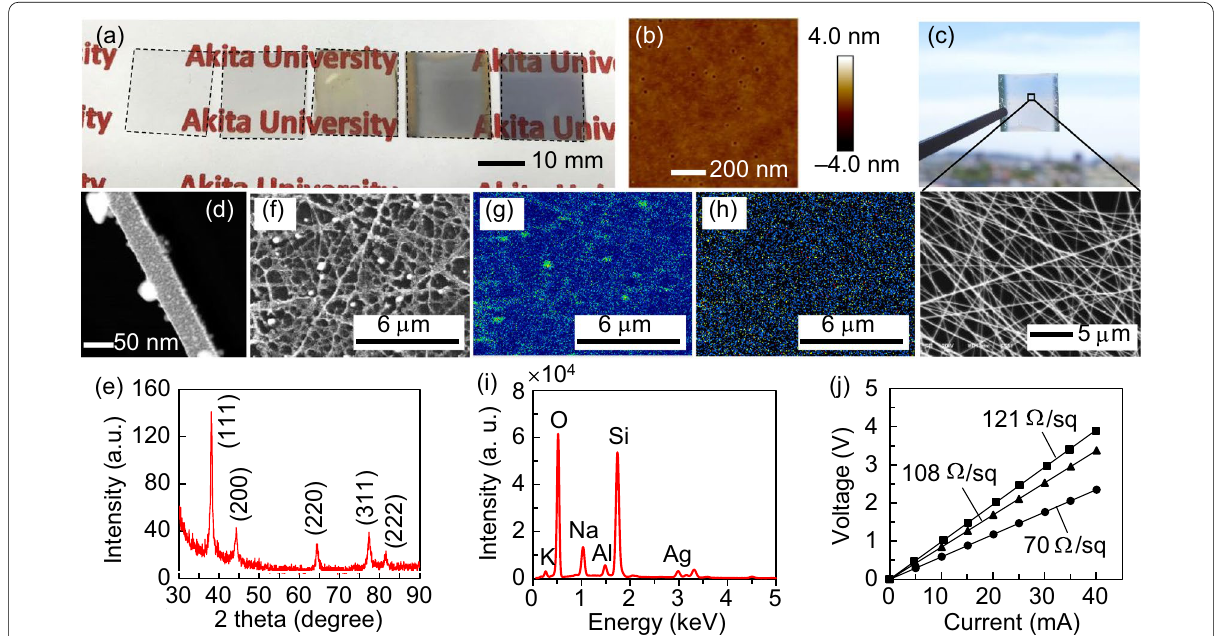
Fig. 2 a States of the specimens during the experiment. b AFM image of Pt sputtered on a glass substrate. c Optical and FE-SEM images of the specimen after heating. d HAADF-STEM image of Ag NF. e XRD pattern of Ag NF. EDX analysis results of the Ag NF network: f SEM image, g Ag, and h C distribution mappings, and i qualitative analysis of the area shown in ( f ). j Current–voltage curves of the specimens measured using